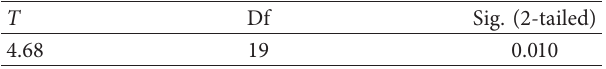
Table 5: One-sample t -test results for the learners’